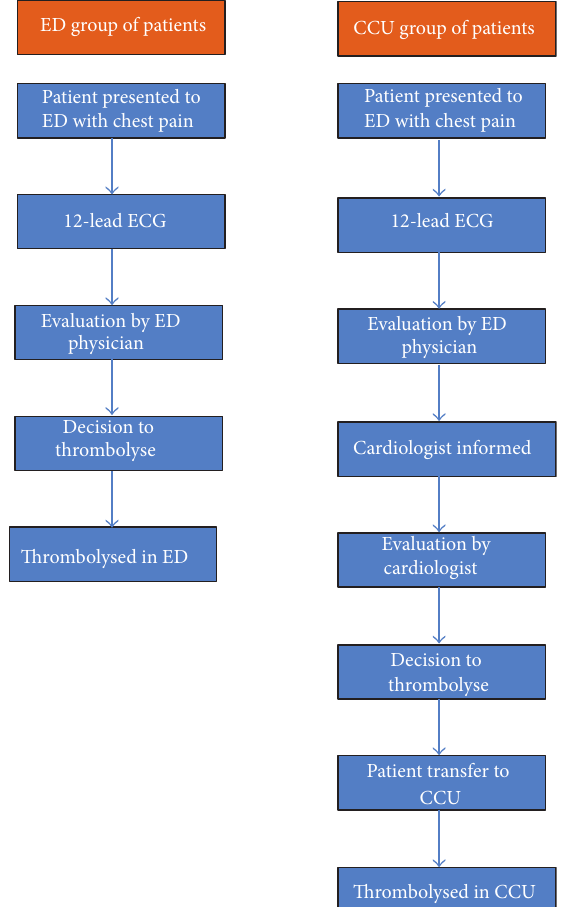
Figure 1: Flow chart showing the process of thrombolysis in ED and CCU